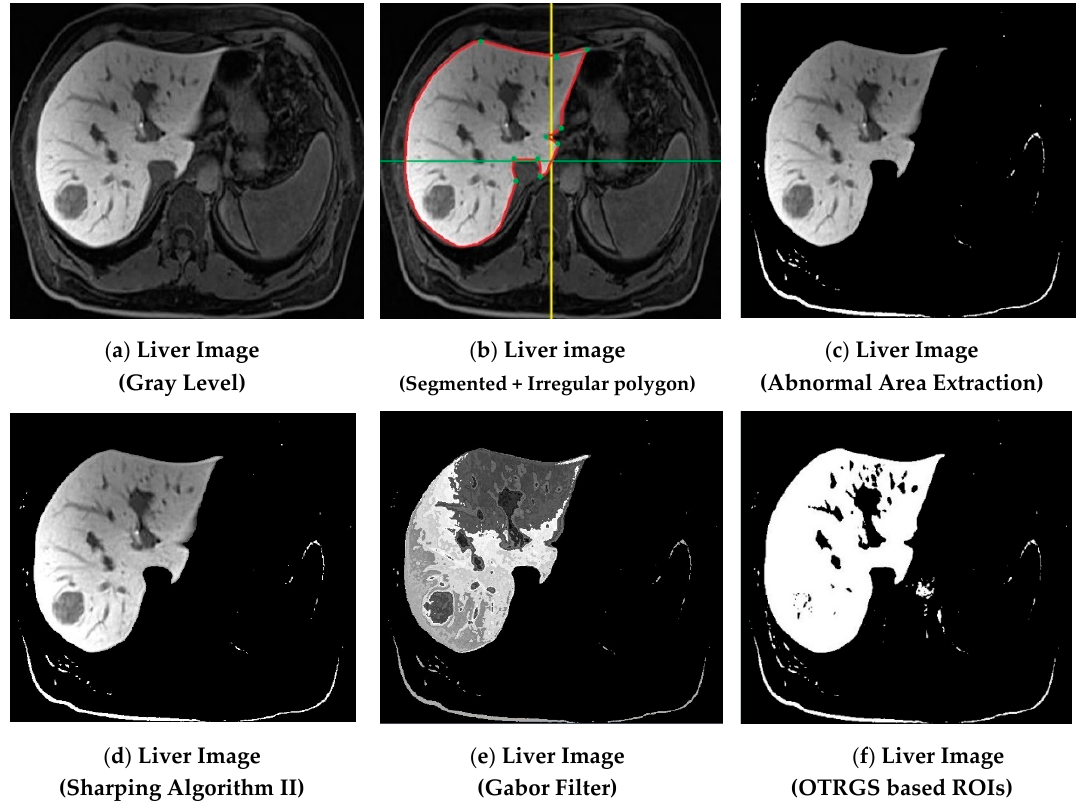
Figure 3. Otsu thresholding-based region growing segmentation (OTRGS) framework for liver cancer.